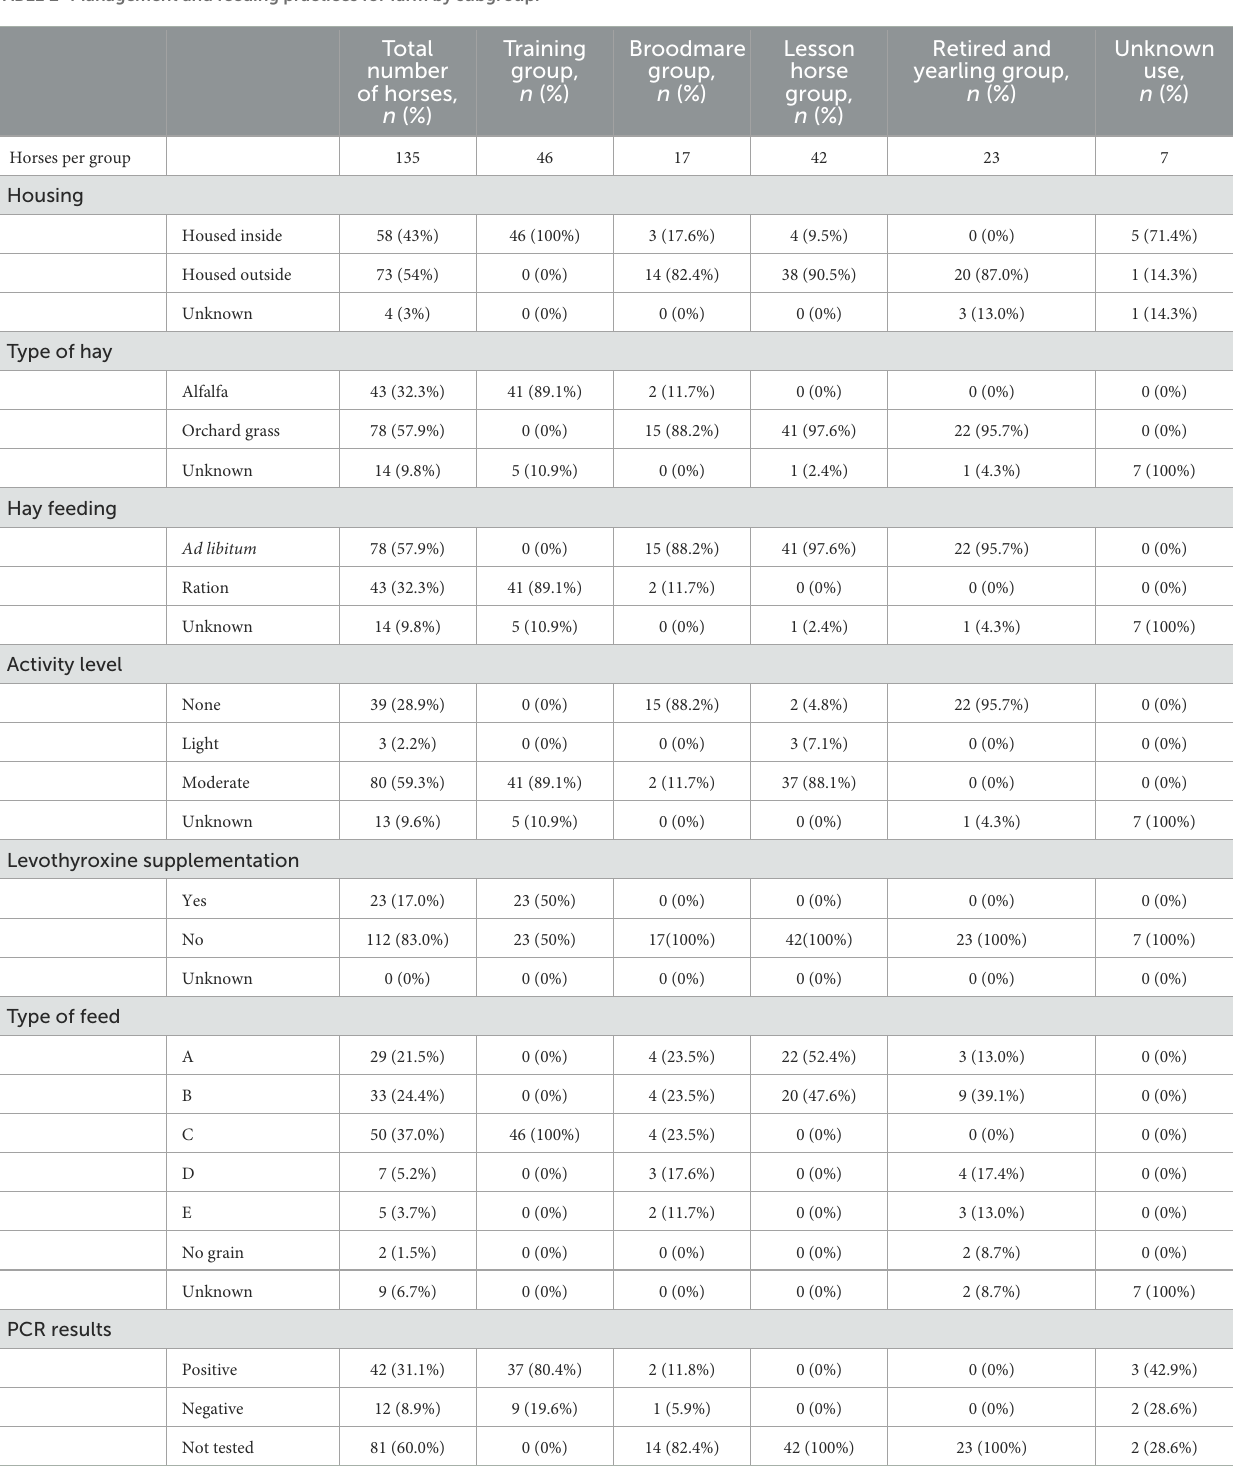
Training group, n (%)